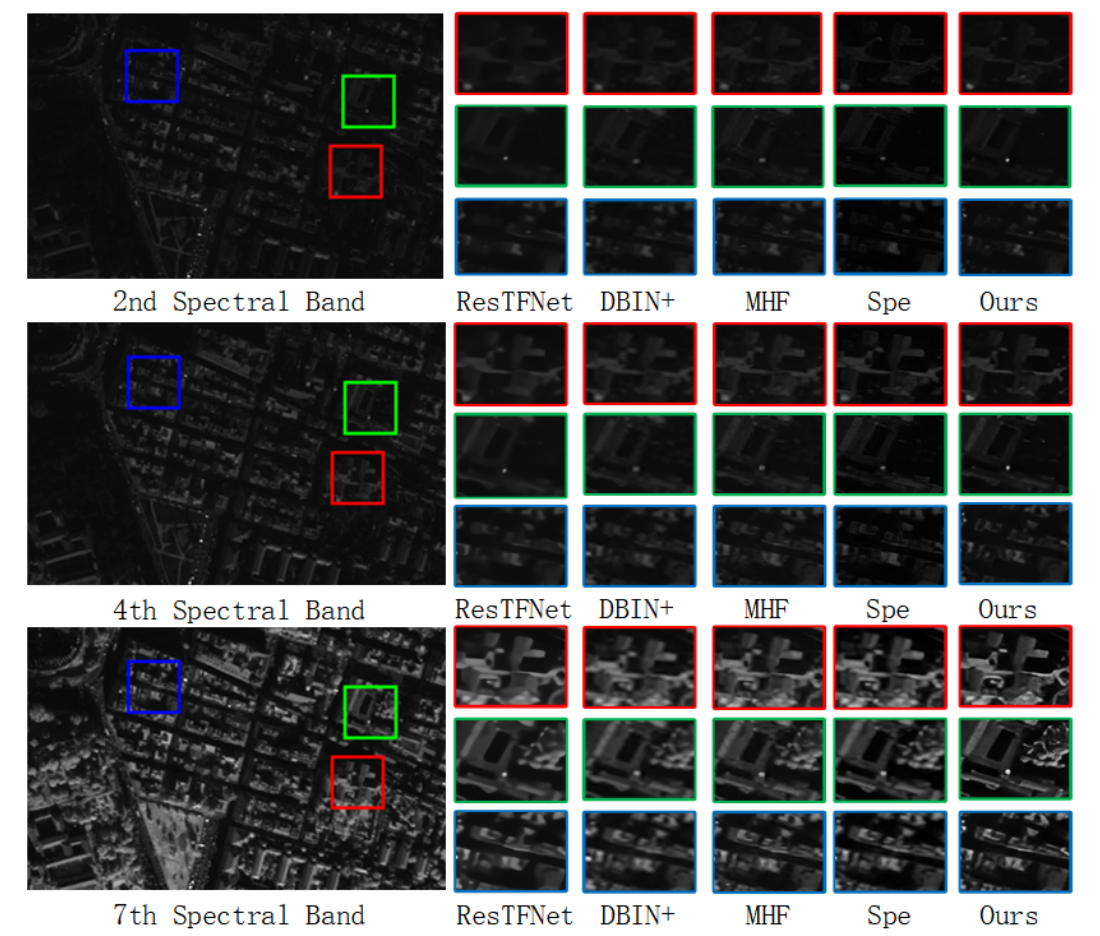
Figure 10. The visual comparisons of fusion results obtained by different methods on World View- 2(WV-2) dataset.